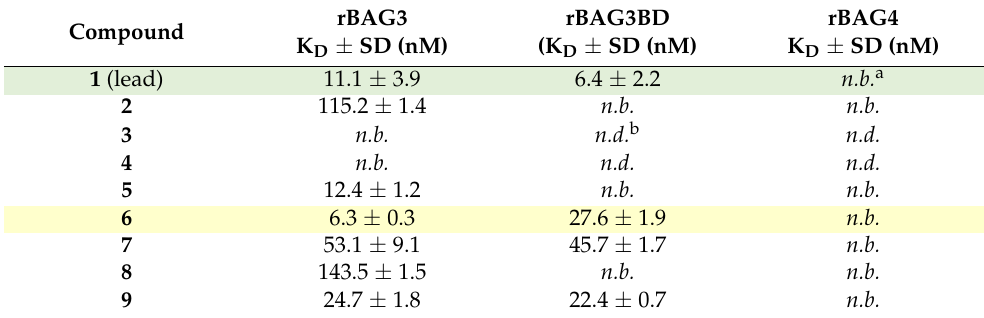
Table 1. SPR assays of compounds 1 – 9 on rBAG3 protein full length, BAG3BD, and BAG4.